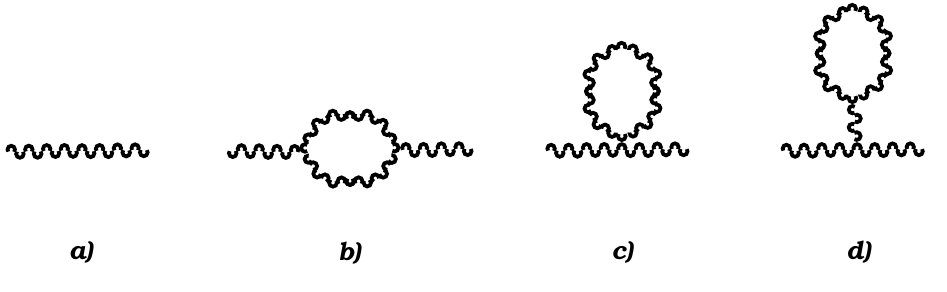
Figure 1 . One-loop diagrams for the propagator h ϕ ( z ) ϕ (0) i